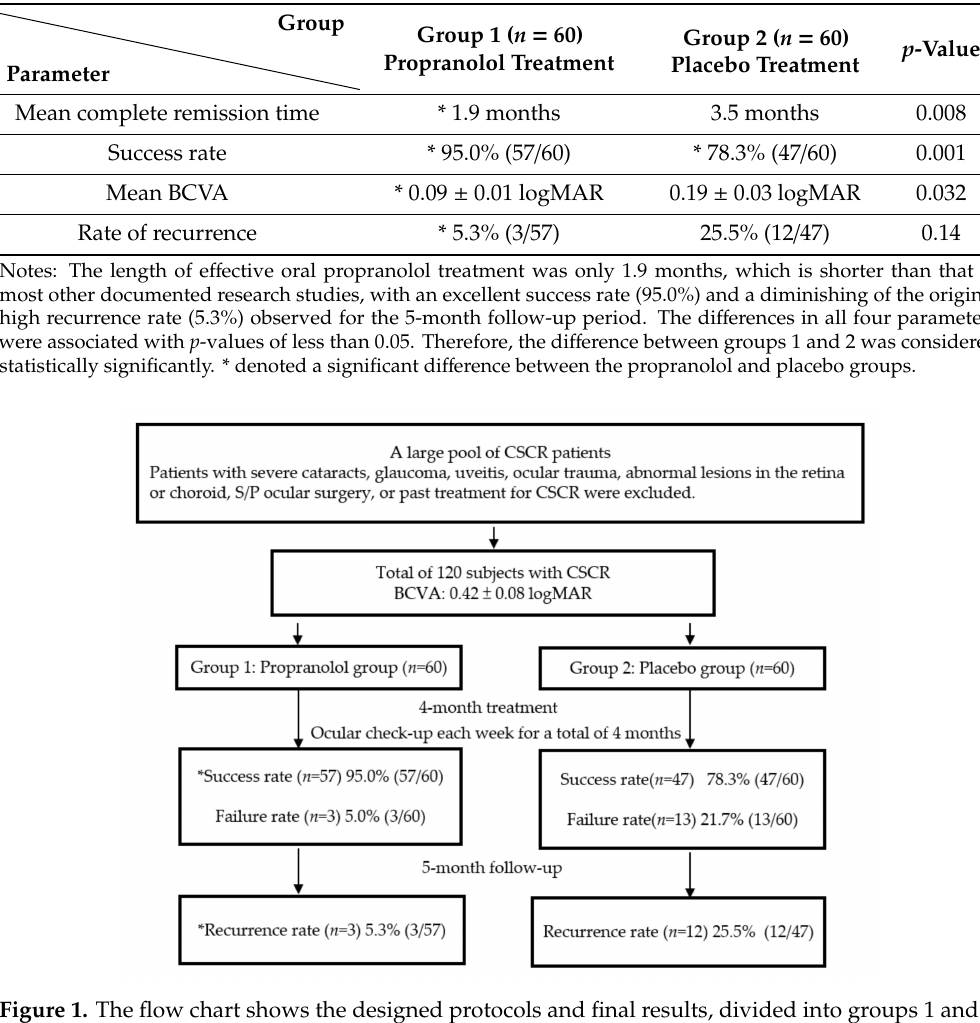
Table 1. Changes in the parameters after our treatment protocols in the 120 patients with CSCR.